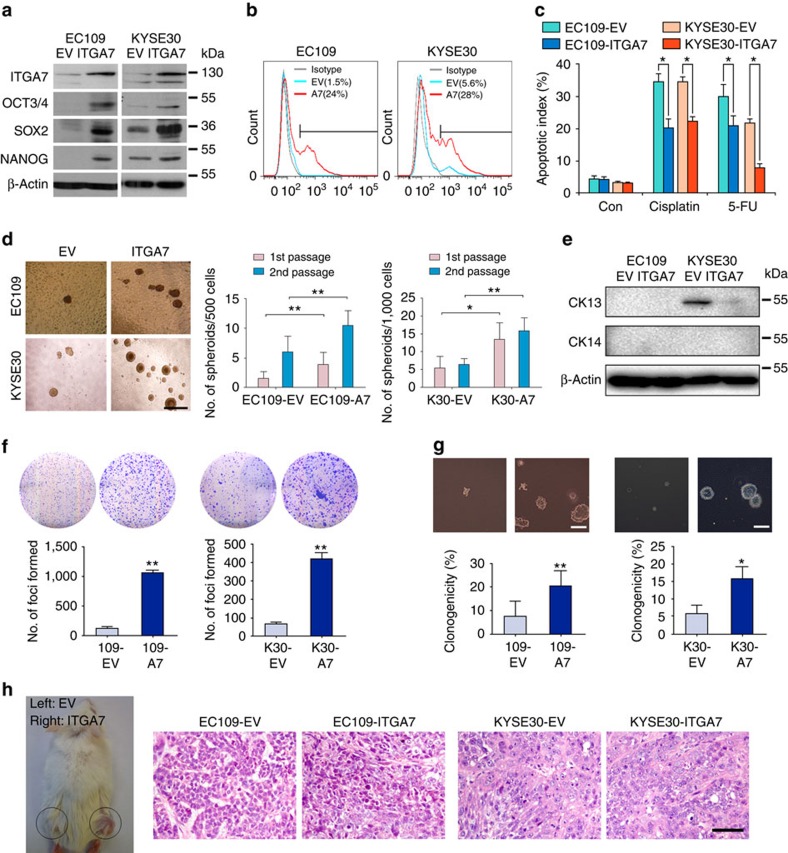
Ectopic overexpression of ITGA7 enhances CSC properties in OSCC cells.(a) Expression of ITGA7 and stemness-associated genes was detected by western blotting in ITGA7- and empty vector (EV)-transfected cells. β-Actin was used as a loading control. (b) The percentage of ITGA7+ cells was compared by FACS between ITGA7- and EV-transfected cells. (c) By apoptosis assay, the anti-apoptotic ability of EC109 and KYSE30 was enhanced after ITGA7 transfection. The apoptotic index was calculated from three independent experiments and presented as mean±s.d. (d) Spheroid formation assay shows the self-renewal ability was enhanced in ITGA7-transfected cells. The values indicate the mean±s.d. of two separate experiments with 24 wells per condition. Scale bar, 500 μm. (e) Expression of CK13 and CK14 was detected by western blot analysis in ITGA7-transfected and control cells. (f,g) Representative images and summaries of foci formation (f) and soft agar assays (g, Scale bar,200 μm) performed in ITGA7-transfected and control cells. The values indicate the mean±s.d. of three independent experiments. (h) Representative of tumours formed in NOD/SCID mice injected with the indicated cells. H&E staining of tumours confirmed a malignant phenotype. Scale bar, 50 μm. Statistics: (c,d,f,g) Student t-test. *P<0.05; **P<0.001.